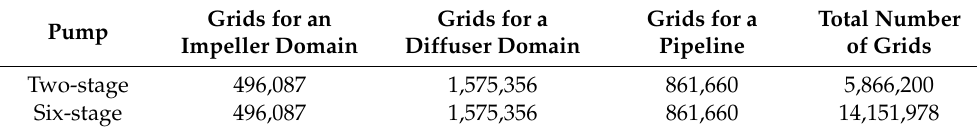
Figure 5. Mesh of six-stage centrifugal pump and two-stage centrifugal pump. Table 5. Detailed information of